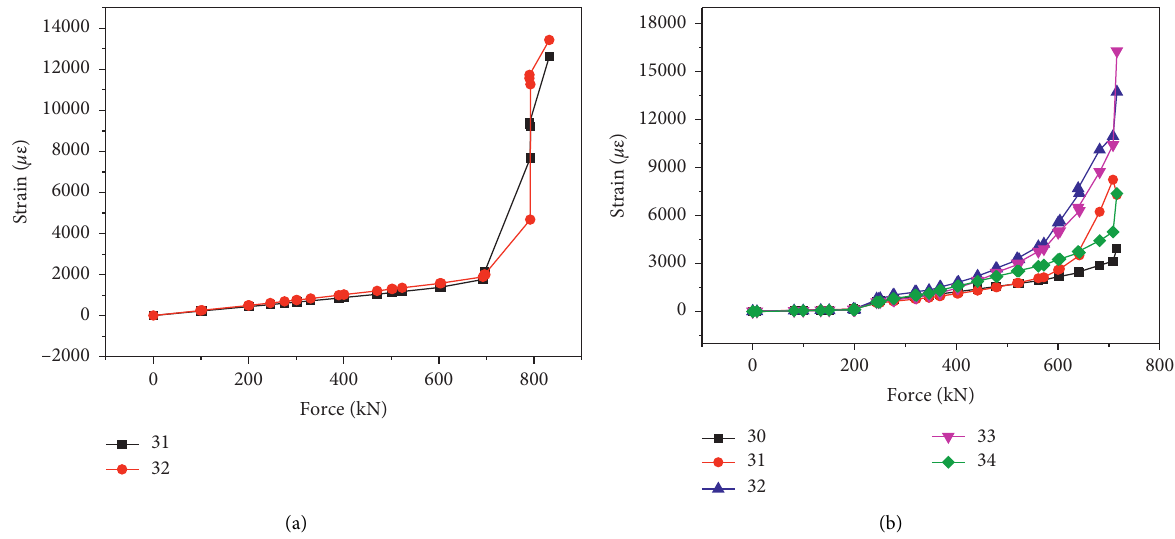
Figure 25: Load-strain curves of bottom steel plates of (a) SC-P3 and (b) SC-P5.